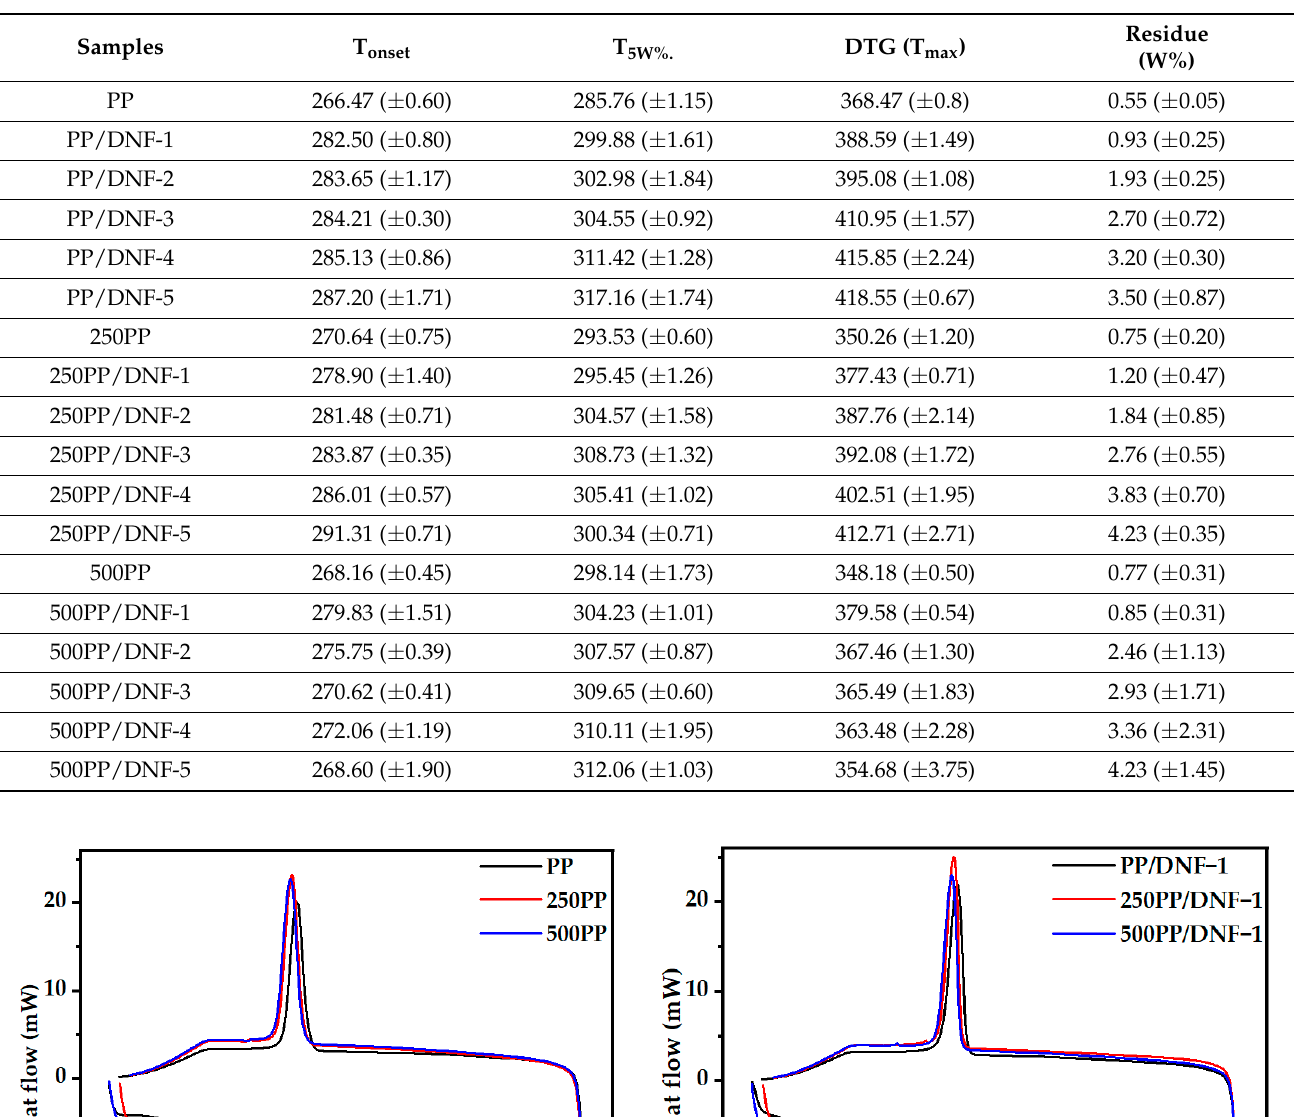
Table 2. Thermal characteristic of the composite samples.